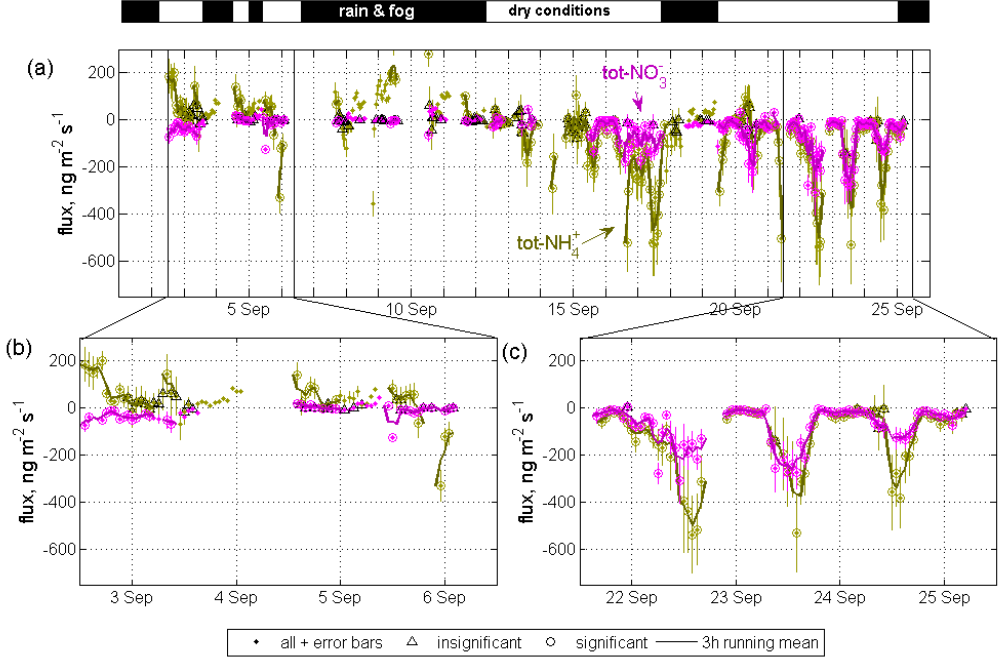
Fig. 4. Time series of tot-NH + and tot-NO − fluxes in ngm − 2 s − 1 (in terms of N) calculated using the AGM at the Weidenbrunnen site. 4 3 An overview about the entire flux data set is given in panel (a) ; panels (b) and (c) show contrasting episodes: fluxes under cooler and foggy conditions (b) and fluxes during warmer and sunny conditions (c). Shown are all flux data in green and magenta dots; insignificant flux data (black triangles) are separated from significant flux data (green and magenta circles ; under conditions without rain, RH < 95%, and high visibility,). Additionally, a 3h running mean (thick colored line) through the significant flux data is